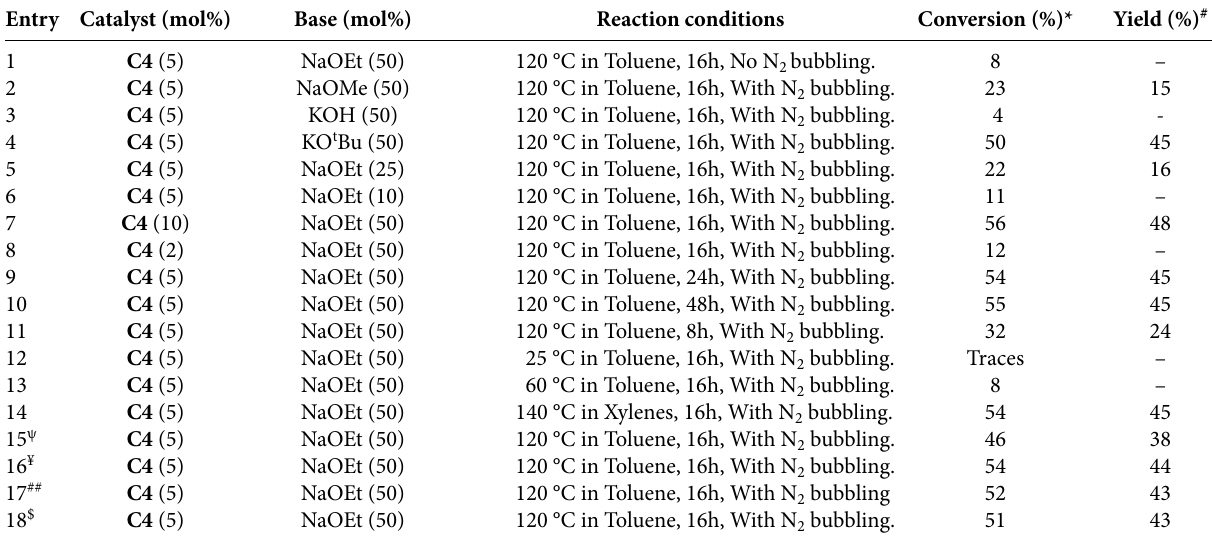
Table 2: Catalysis data for acceptorless dehydrogenation of 1-phenylethanol to yield acetophenone; catalyzed by the nickel(II)diphosphine complex C4 under various reaction conditions. Entry Catalyst (mol%) Base (mol%)